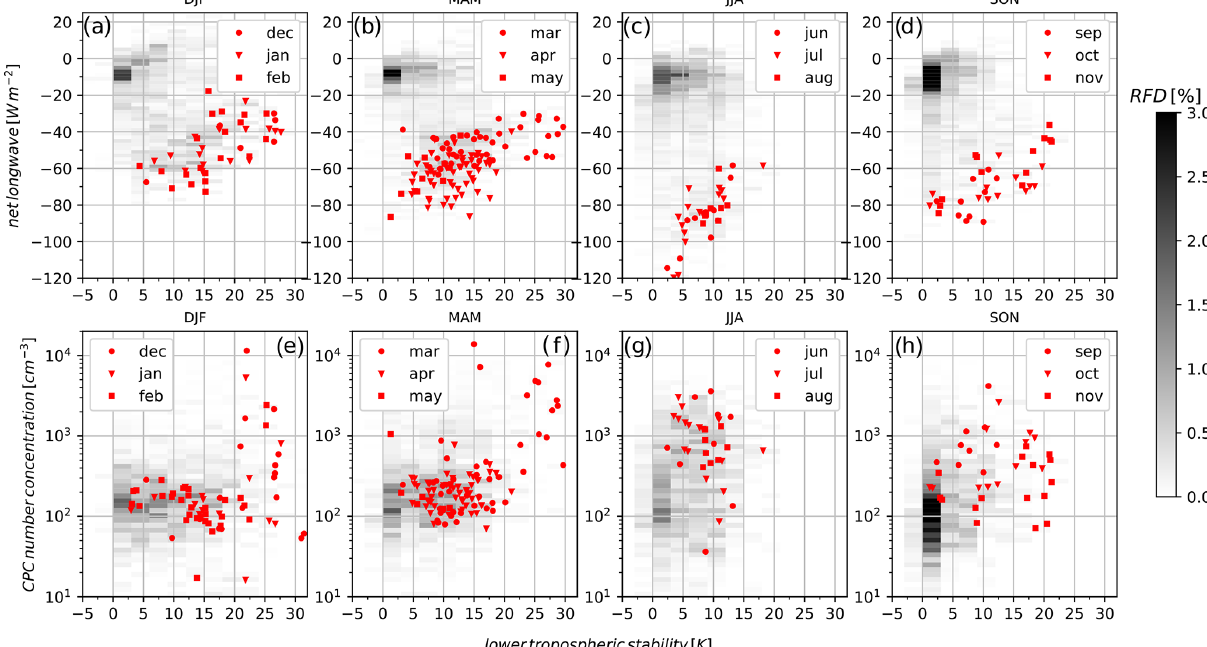
Figure 8. Relative frequency distributions (RFDs, gray contours) of (a–d) net longwave radiation (LWN, [Wm − 2 ]) as a function of lower tropospheric stability (LTS, [K]) for (a) winter, (b) spring, (c) summer and (d) autumn. (e, f) Relative frequency distributions of near-surface CPC concentrations [cm − 3 ] as a function of LTS. LWN and CPC concentrations are taken within 10min of each radiosounding profile used to estimate LTS. Red symbols represent the individual relationships between LTS and LWN and CPC values within 10min of the radiosounding during the clear-sky periods; each month within the season is represented by a different